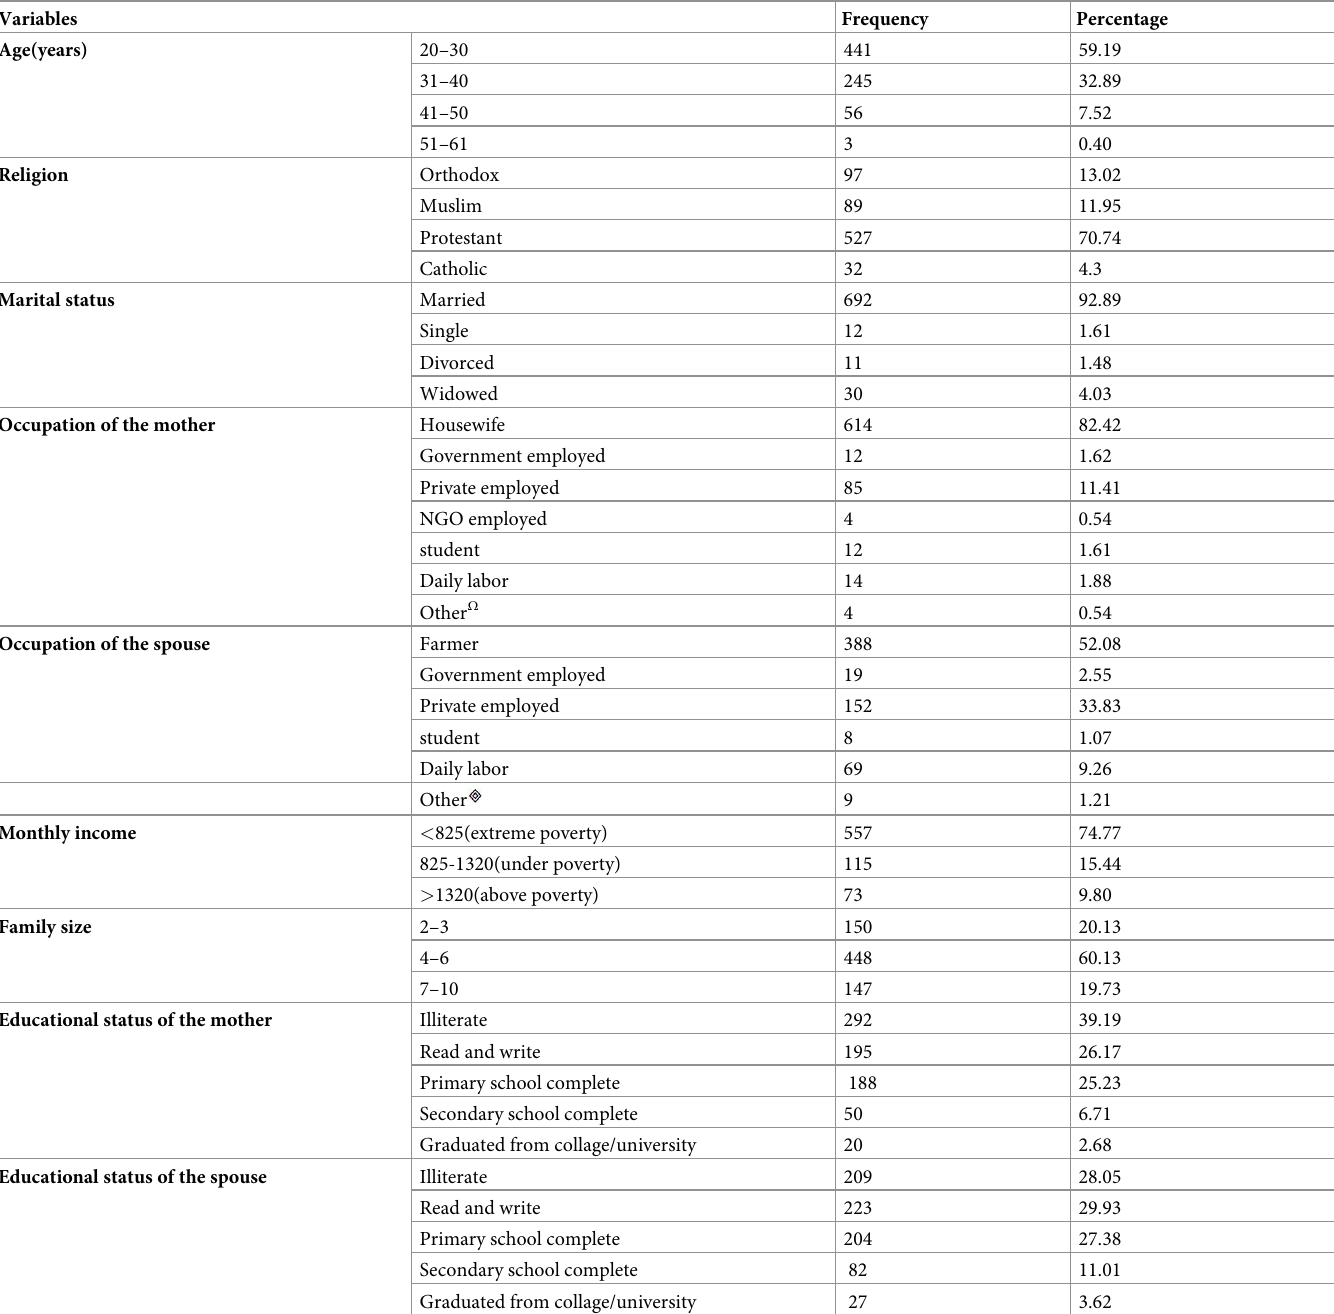
Table 1. Socio-demographic and economic characteristics of study participants in Sidama Zone, southern Ethiopia, April 2019 (n = 745).